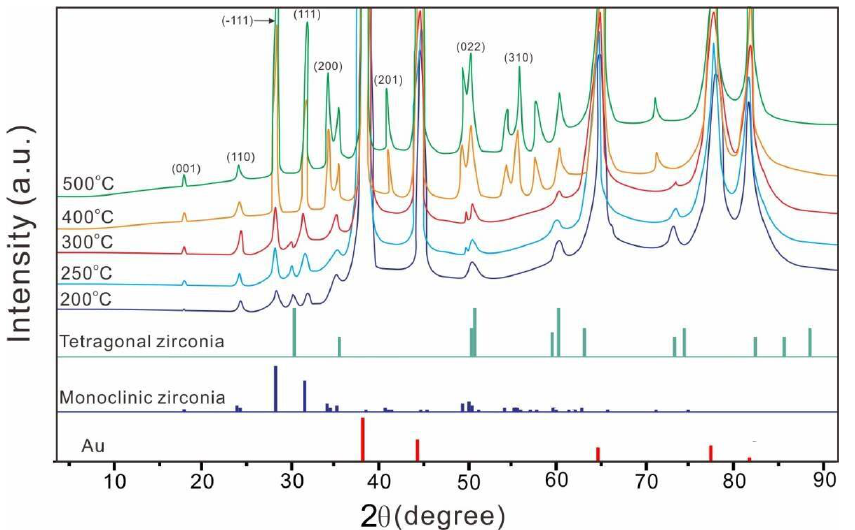
Figure 3. Representative XRD analysis of zirconia micro-nanoflakes synthesized at 200–500 °C. The XRD spectra of Au, monoclinic zirconia (ZrO 2 ), and tetragonal zirconia (ZrO 2 ) are from the database (No.00-004-0784, 00-037-1484, and 00-002-0733).